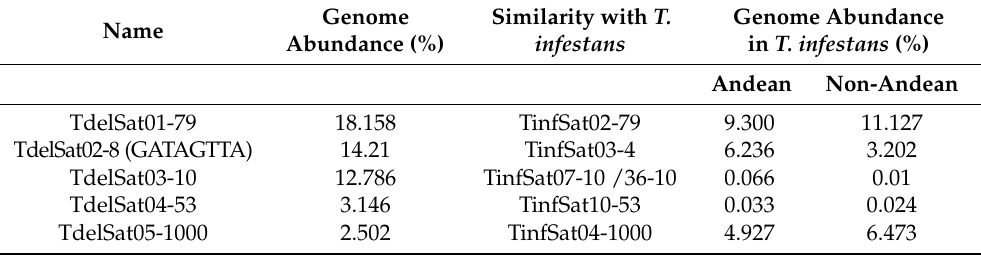
Table 2. Data of the satDNA families found in T. delpontei : name, genome abundance in T. delpontei , presence in T. infestans , and genome abundance in the Andean and non-Andean T. infestans lineages. Genome Similarity with Name Abundance (%)